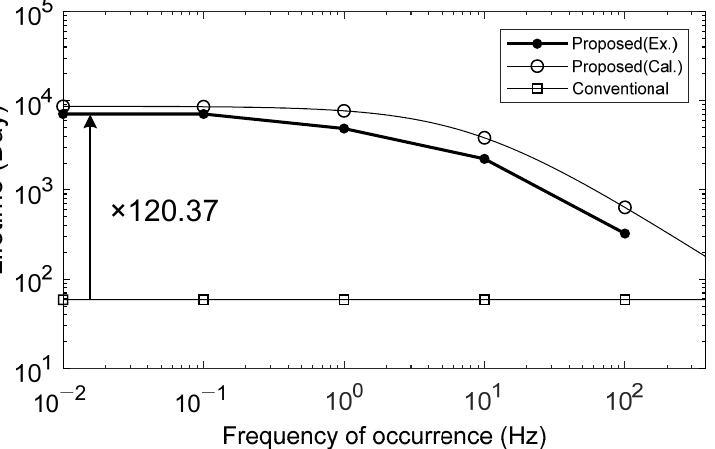
Figure 18. Lifetime of a 7500 mAh battery in different monitoring systems as a function of abnormality occurrence frequency.